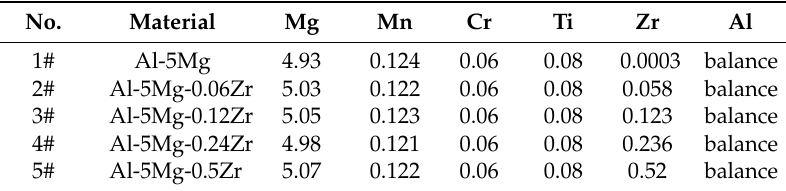
Table 1. Chemical compositions of wire electrodes (wt